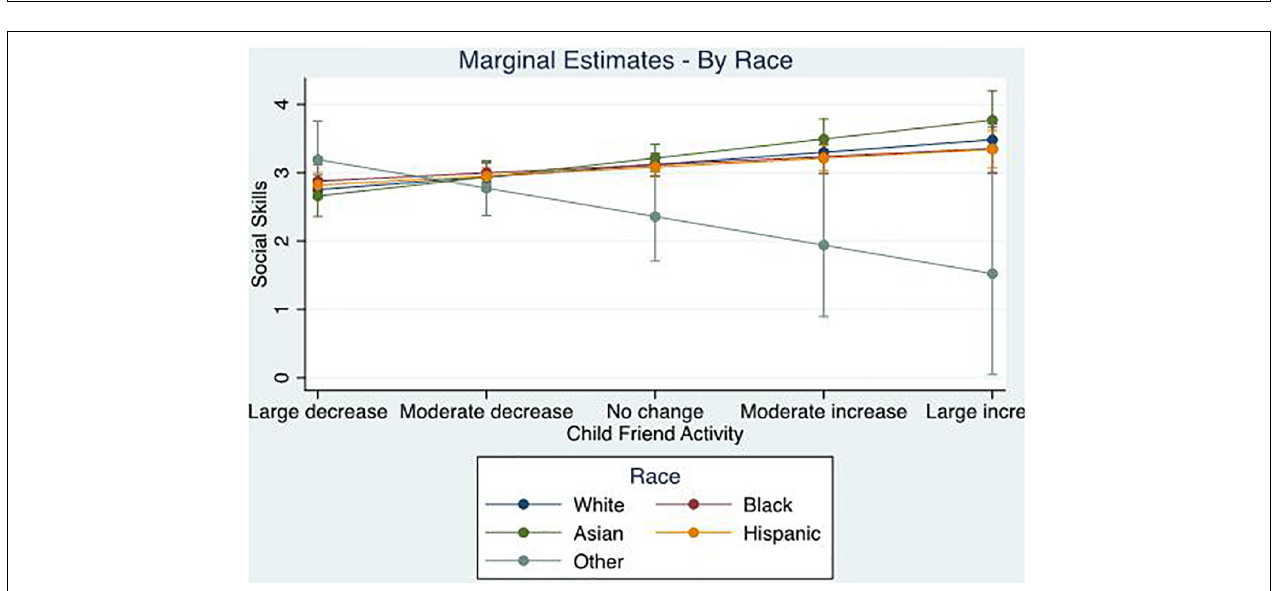
FIGURE 1 | Marginal estimates for change in social skills by race/ethnicity: change in schoolwork/homework.